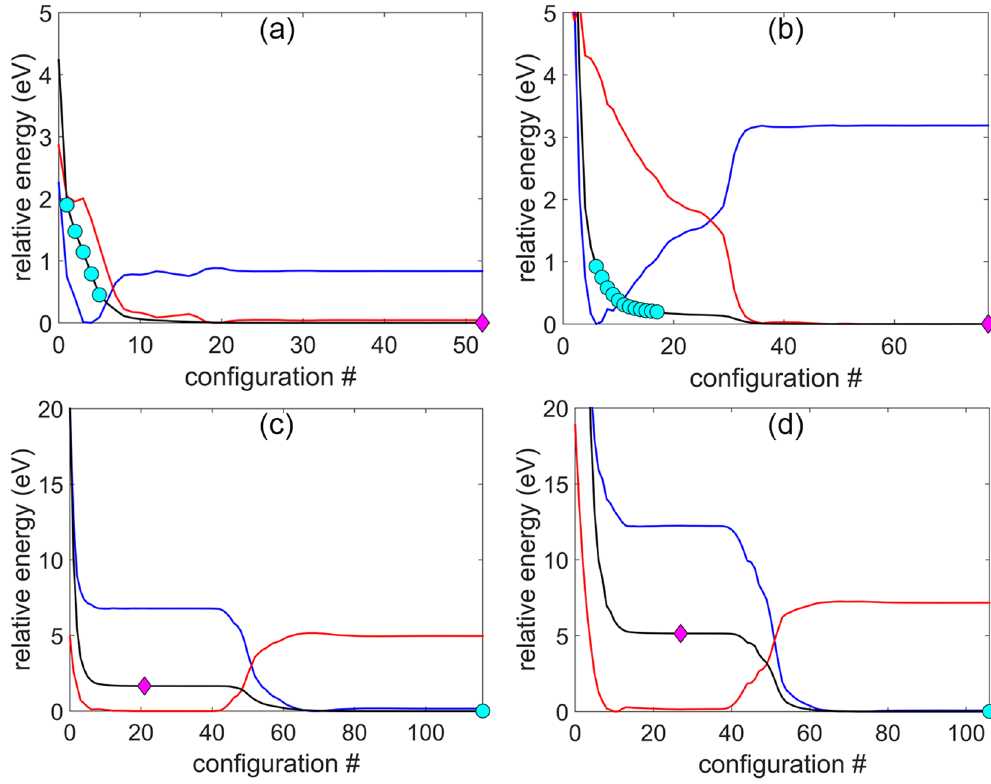
Figure 2. Relative energy of Ag shell (blue), Cu core (red) and whole particle (black) during relaxation for ( a ) Ag Cu ( b ) Ag Cu ( c ) Ag Cu and ( d ) Ag Cu . The structure at the beginning of relaxation is 72 55 132 147 212 309 312 561 chiral icosahedron for ( a , b ) and anti-Mackay icosahedron for ( c , d ). The relative energy is measured with respect to the minimum value of the respective component under consideration. The configurations corresponding to anti-Mackay icosahedron (magenta diamond) and chiral icosahedron (cyan circle) used for the analysis of core, shell energy are marked in each